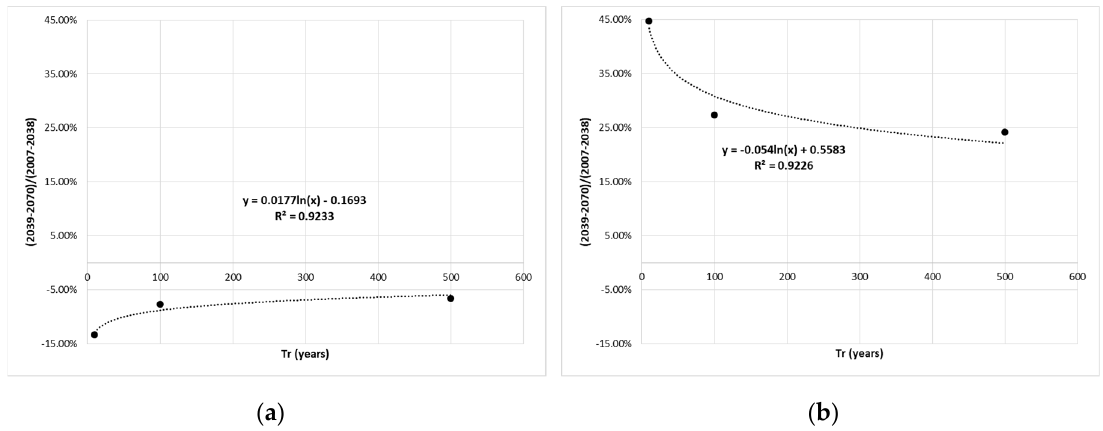
Figure 13. Second Stage (2039–2070)/1st Stage (2007–2038) economic damage ratio trend line in terms of return periods. ( a ) ANA—BCC-CSM1-1-m; ( b ) ANA—MRI-CGCM3.